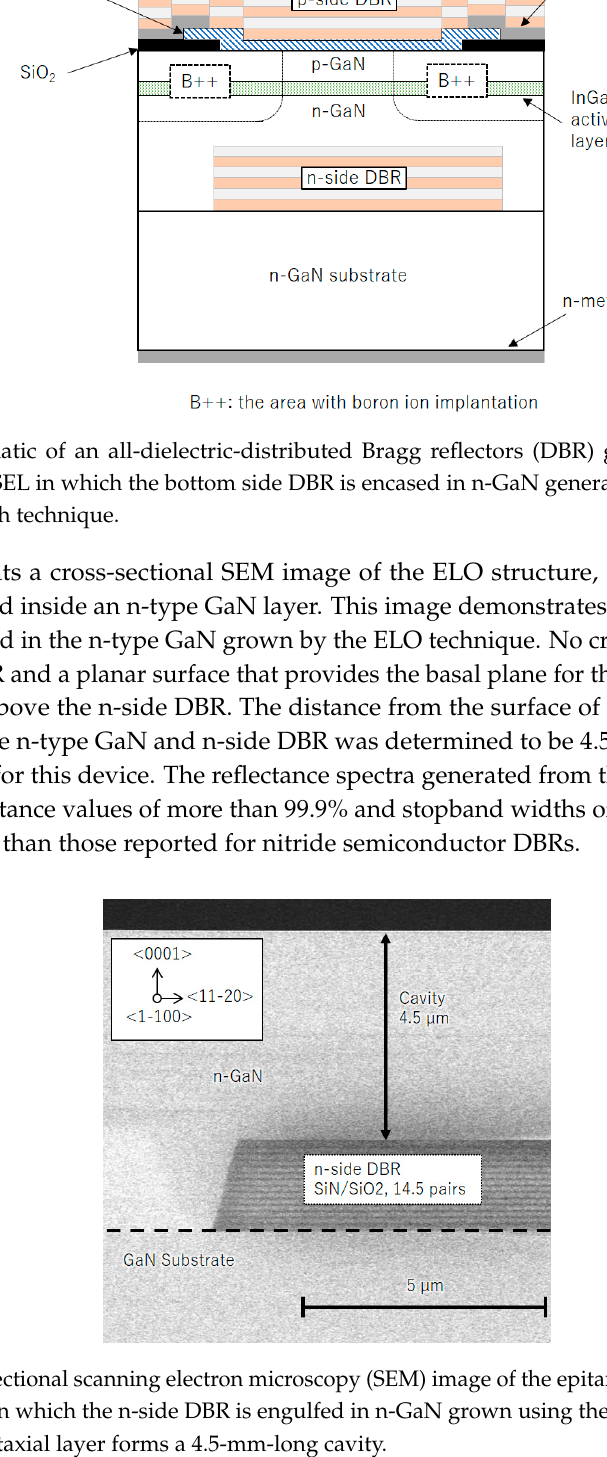
Figure 4. I–V and I–L curves generated by an all-dielectric-DBR GaN-based vertical-cavity surface- emitting laser (VCSEL). Here, I th was 18 mA and the maximum output power was 1.1 mW, the highest value reported to date for this type of device. The kinks in the I–L curve suggest multimodal operation for the lateral mode, presumably due to the absence of lateral optical confinement. Figure 5. Spectra obtained from the all-dielectric-DBR GaN-based VCSEL above and below the threshold current (18 mA). Spectrum ( a ) was obtained at 20 mA and shows a single longitudinal mode at 453.9 nm and a half width at maximum of 0.05 nm. The latter value is equivalent to the resolution